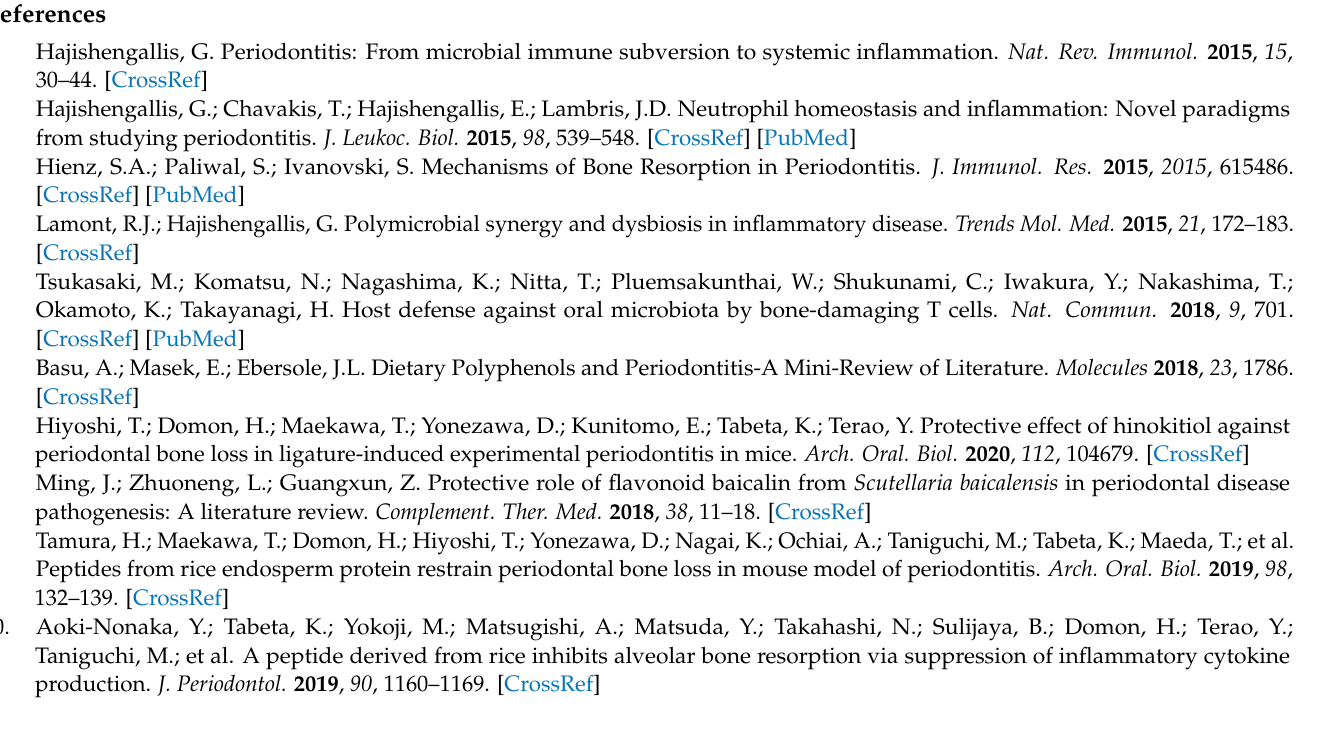
Figure S3: Cytotoxicity of ERM or PC or JSM to